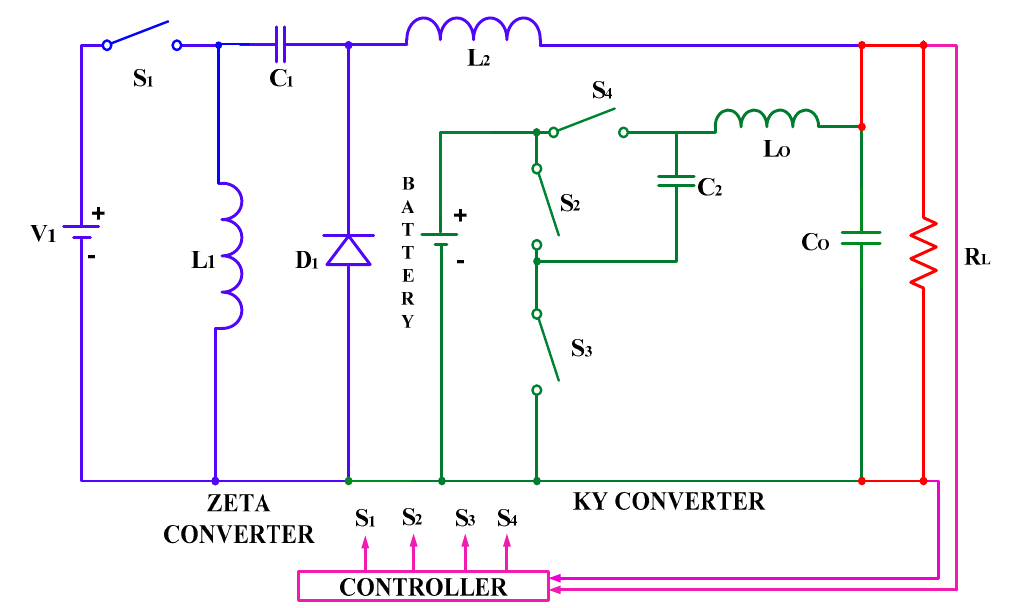
Figure 6. Proposed modified three-port Zeta-KY dc-dc bidirectional